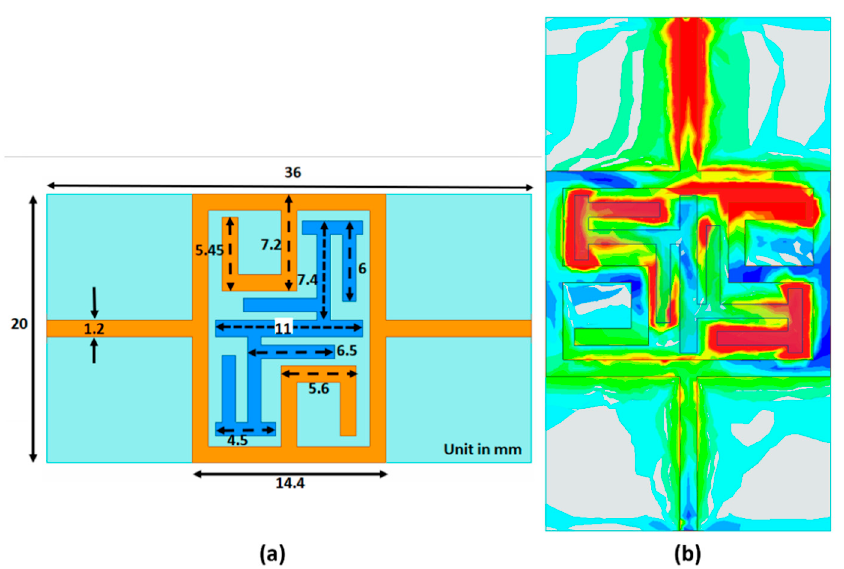
Figure 7. Overview of bandstop sensor structure with dimension ( a ). E-field distribution on the bandstop filter ( b ).